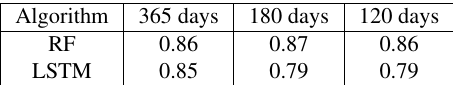
Figure 2. Confusion matrix(Recall values) for random forest classifier (180